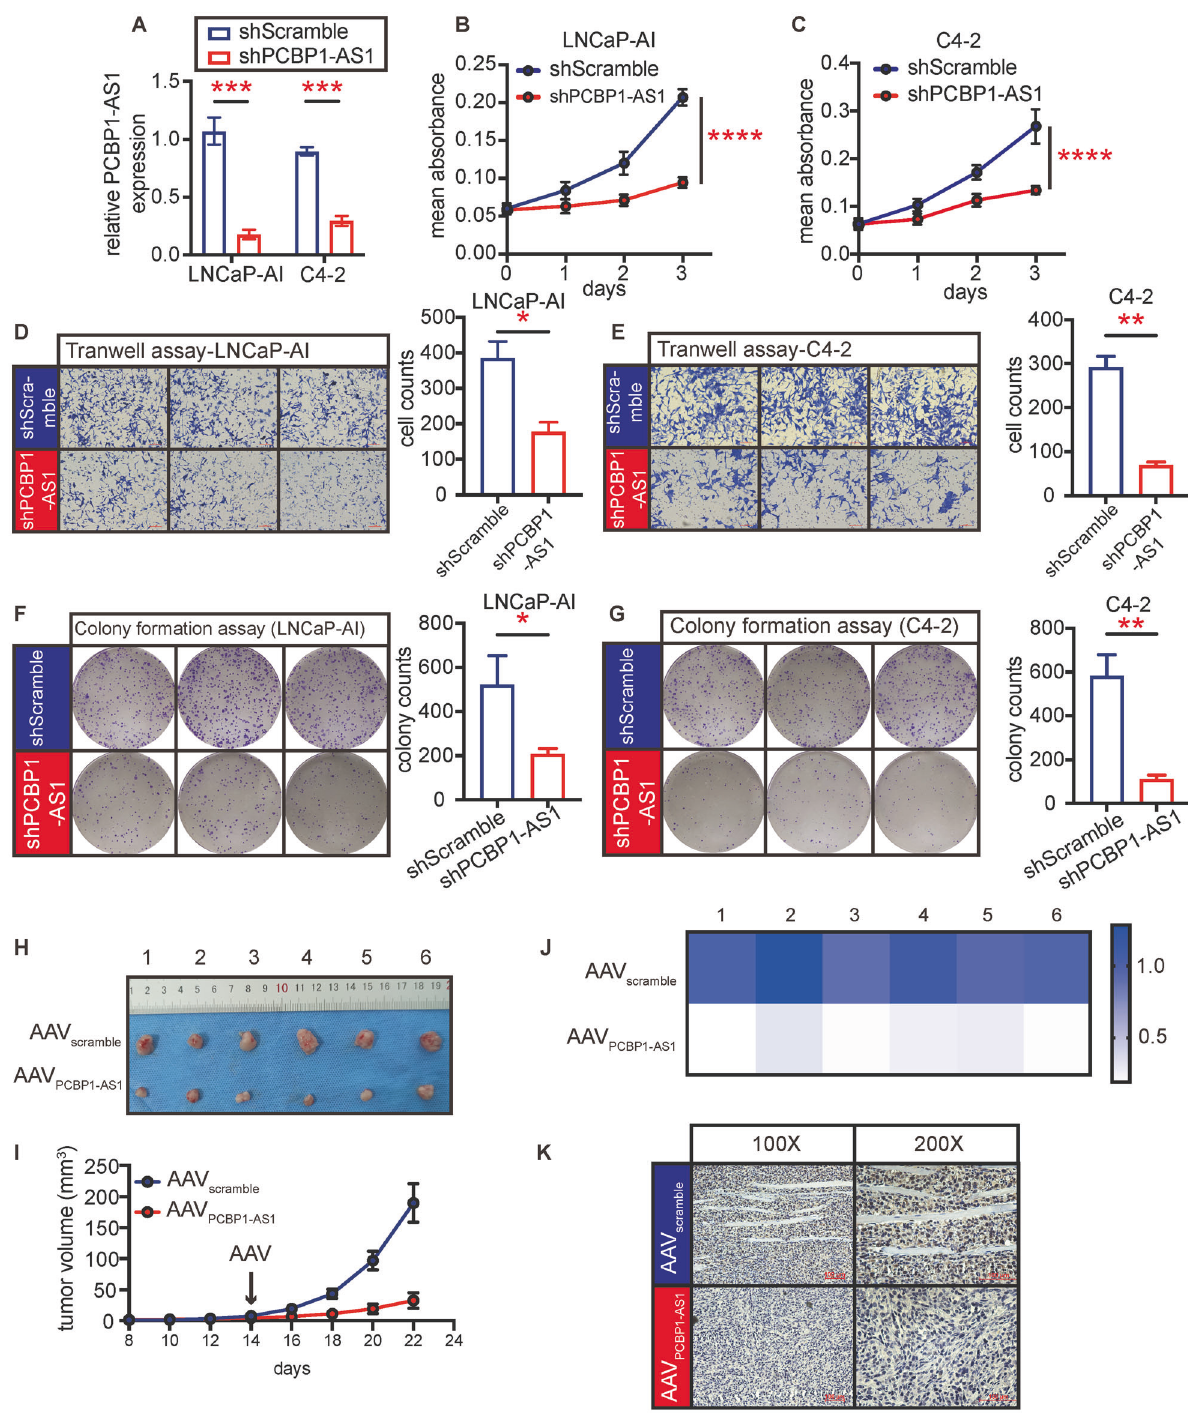
Fig. 2 Targeting PCBP1-AS1 signi fi cantly affects tumor biological functions in vivo and in vitro. A Knockdown ef fi ciency of PCBP1-AS1 in LNCaP-AI and C4-2 cell lines. B , C Cell viability detection by MTT assay. The P value at day 3 was calculated. D , E Cell migration detection by Transwell assay. The left panel performed indicated groups ’ graph, right panel is the summary of cell counts. F , G Cell proliferation detection by colony formation assay. The left panel performed indicated groups ’ graph, right panel is the summary of colony counts. H Graph of transplant tumors in in vivo experiment. I Tumor growth rate of in vivo experiment. Tumor volume was calculated at the scale of mm 3 . J PCBP1-AS1 expression in indicated groups. Expression was detected by qPCR. Panels A – G repeated three times, panels H – K repeated two times, with six biological replicates each time. Signi fi cance: * P <0.05, ** P <0.01, *** P <0.001, **** P <0.0001.